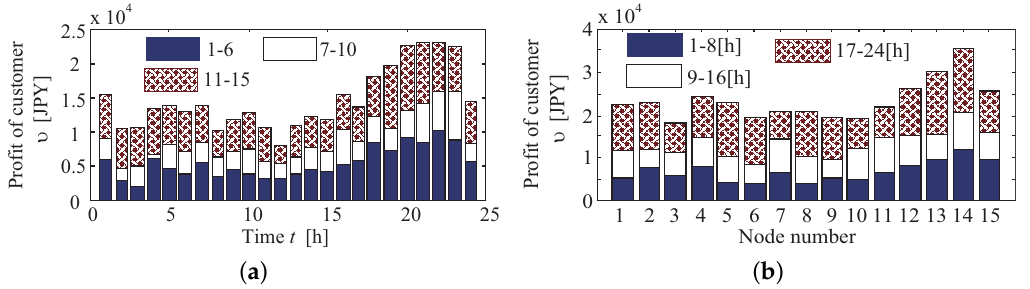
Figure 13. Profit of the customer from reactive power incentive (Case 3). ( a ) Hourly profits of each node and ( b ) end-of-day profit for customers at each node.